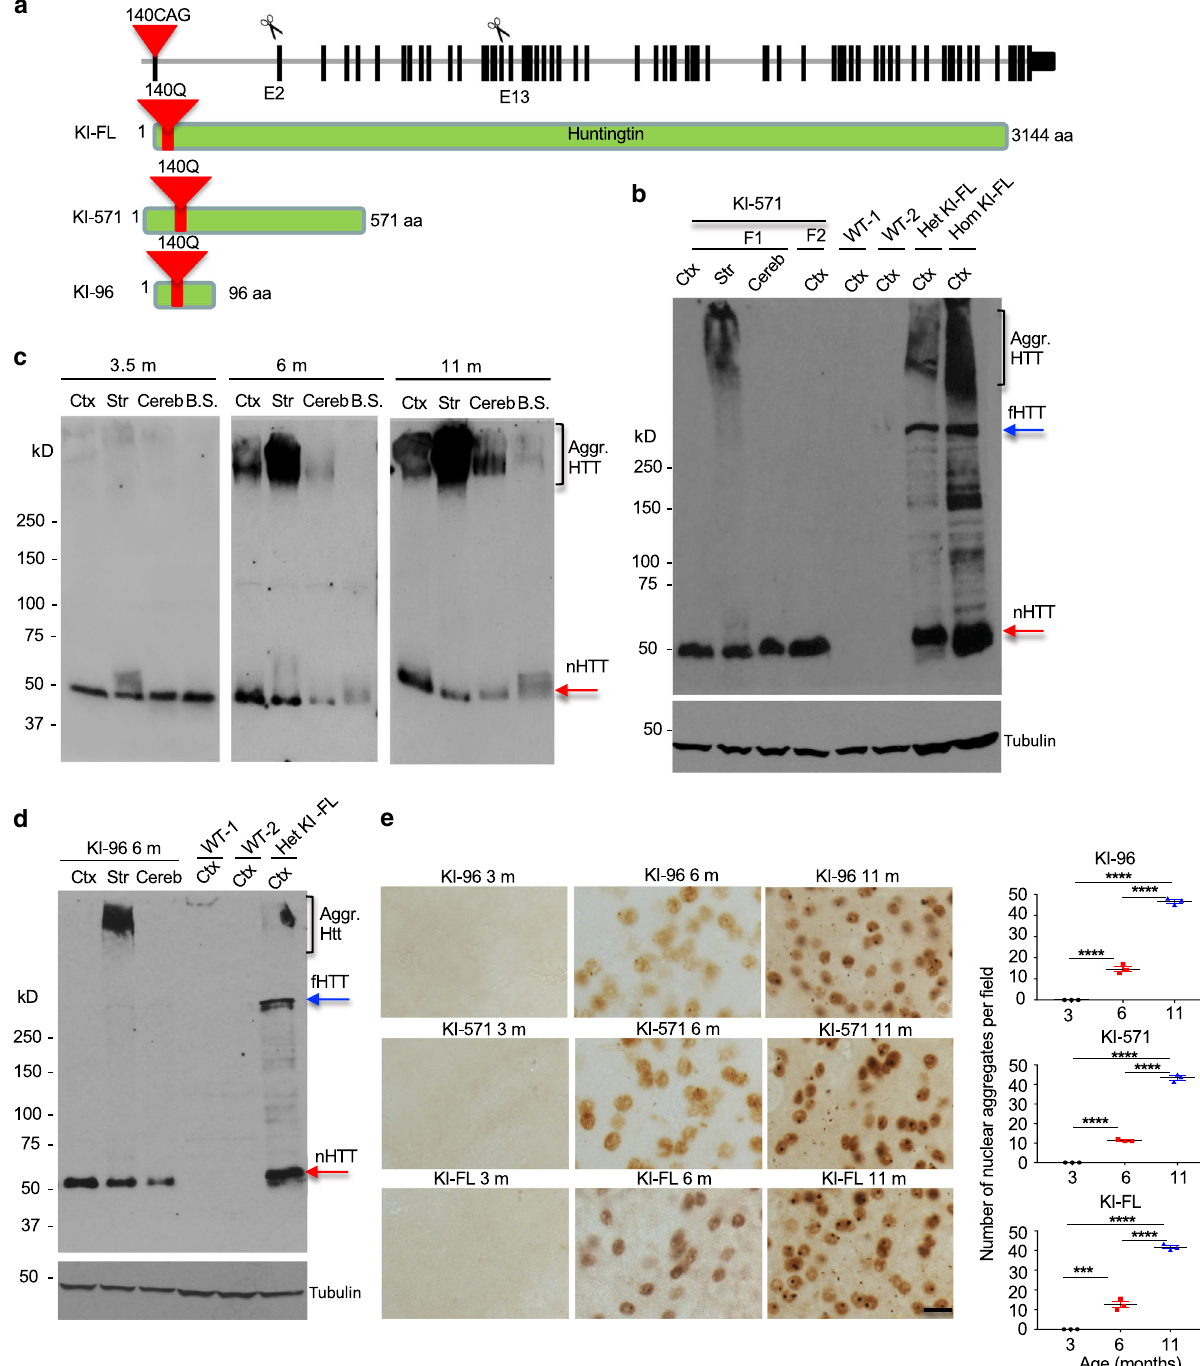
Fig. 2 Generation of HD KI mice expressing different N-terminal HTT fragments. a Generation of new HD KI mouse models by truncating exon 2 and exon 13 of the mouse HTT gene in HD140Q KI (KI-FL) mice via CRISPR/Cas9, resulting in the expression of truncated mutant HTT containing the fi rst 96 and 571 amino acids in KI-96 and KI-571 mice, respectively, with an additional 140Q repeat. b mEM48 western blotting showing the speci fi c expression of mutant HTT in KI-571 mouse brains. This N-terminal mutant HTT (nHTT) is at the same size as the smallest mutant HTT in KI-FL mouse brain and forms aggregated HTT in the striatum. c mEM48 western blotting revealing an age-dependent aggregation of mutant HTT in KI-571 mouse brain. d mEM48 western blotting showing the speci fi c expression of mutant HTT in KI-96 mice, which also has the same size as the smallest mutant HTT in KI-FL mouse brain and preferentially forms aggregated HTT in the striatum. More than three times of experiments were performed independently for b – d . In a – d , Ctx cortex, Str striatum, Cereb cerebellum. F1 F1 generation, F2 F2 generation. Aggr. HTT aggregated HTT, nHTT n-terminal HTT, fHTT full-length HTT. e mEM48 immunostaining showing an age-dependent accumulation of mutant HTT in the striatum in KI-96, KI-571, and KI-FL mice. Scale bar: 10 μ m. Quanti fi cation of immunostaining results in Fig. 2e were obtained by counting six images per brain region per mouse ( n = 3 mice per genotype, *** p < 0.001, **** p < 0.0001, one-way ANOVA followed by Tukey ’ s multiple comparison tests, KI-FL, F = 408.1, p < 0.0001; KI-571, F = 1195, p < 0.0001; KI-96, F = 720.8, p < 0.0001). Data are presented as mean values ± SEM. Source data are provided as a Source Data fi